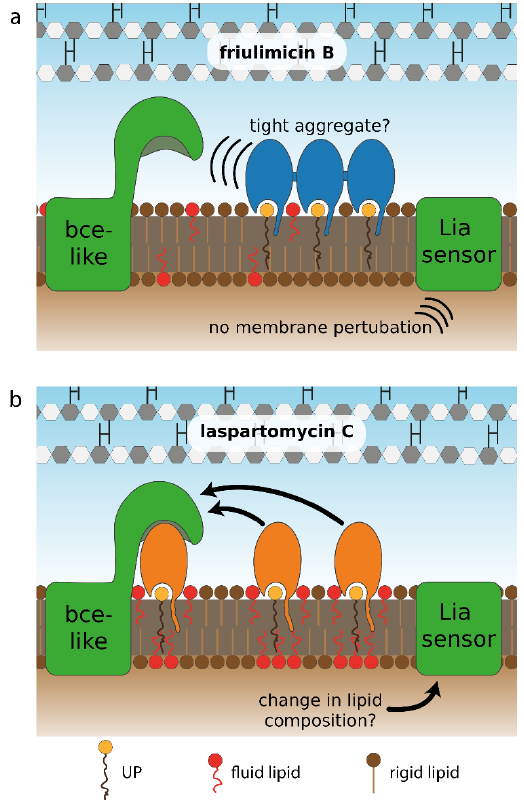
Figure 9. Hypothetical model for differential sensing of friulimicin B and laspartomycin C by Bce-like direct sensors and the LiaFSR damage sensor. ( a ) The proposed ionic interactions between